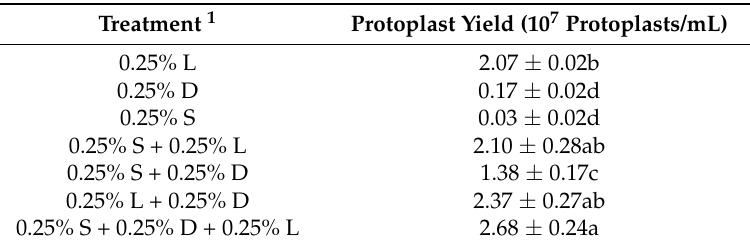
Table 1. Effects of enzyme on protoplast